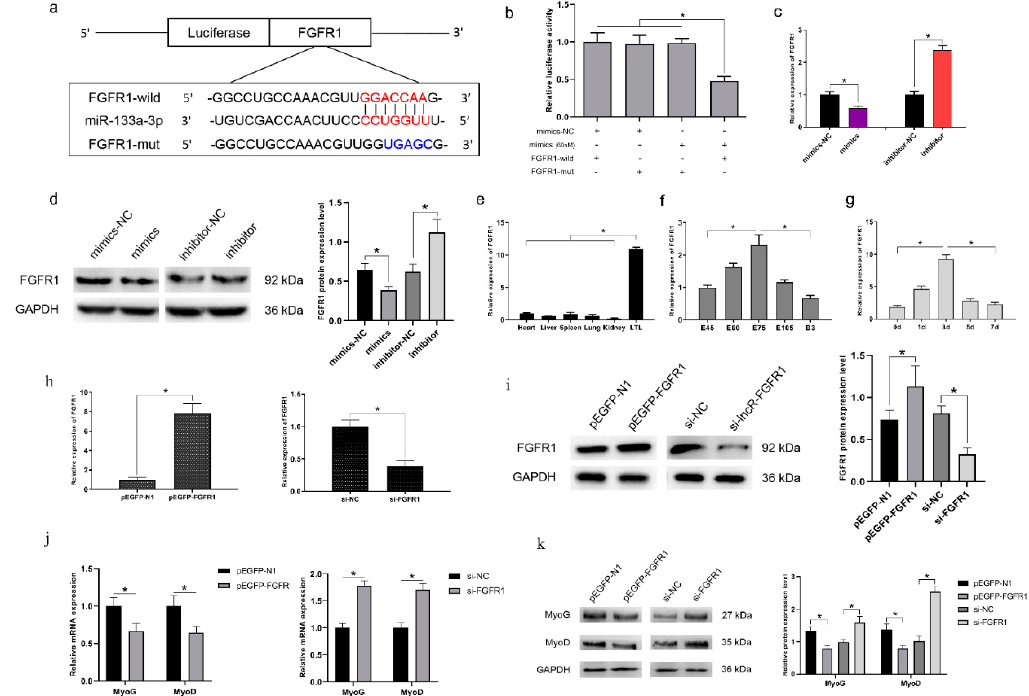
Figure 5. FGFR1 is a target gene of miR-133a-3p and inhibits myoblast differentiation. ( a ) Vectors containing the FGFR1 wild-type (FGFR1-wild) and mutant (FGFR1-mut) sequences were constructed. The miR-133a-3p seed sequence and the FGFR1 mutant sequence are indicated in red and blue, respectively. ( b ) Luciferase assays revealed the suppressive effect of miR-133a-3p on the activity of FGFR1. ( c ) The expression level of FGFR1 in MuSCs transfected with miR-133a-3p mimics or inhibitor. ( d ) The protein expression of FGFR1 in MuSCs transfected with miR-133a-3p mimics or inhibitor. ( e ) The expression pattern of FGFR1 in goat tissues. ( f ) The expression pattern of FGFR1 in the developmental LTL muscle. ( g ) qRT-PCR analysis of FGFR1 expression in MuSCs during 7 days of differentiation. ( h ) qRT-PCR analysis of FGFR1 expression in MuSCs transfected with pEGFP-FGFR1 or si-FGFR1 after 48 h in DM. ( i ) The protein expression of FGFR1 in MuSCs transfected with pEGFP-FGFR1 or si-FGFR1 after 48 h in DM. ( j ) qRT-PCR analysis of mRNA expression of MyoG and MyoD in MuSCs transfected with pEGFP-FGFR1 or si-FGFR1 then cultured in DM for 48 h. ( k ) Western blot analysis of MyoG and MyoD protein expression in MuSCs transfected with pEGFP-N1, pEGFP-FGFR1, si-NC, and si-FGFR1, respectively. Image Pro Plus software (version 6.0, Media Cybernetics) was used to compute the quantification of protein expression. Data are means ± standard error of the mean of at least three biological replicates, * p < 0.05.